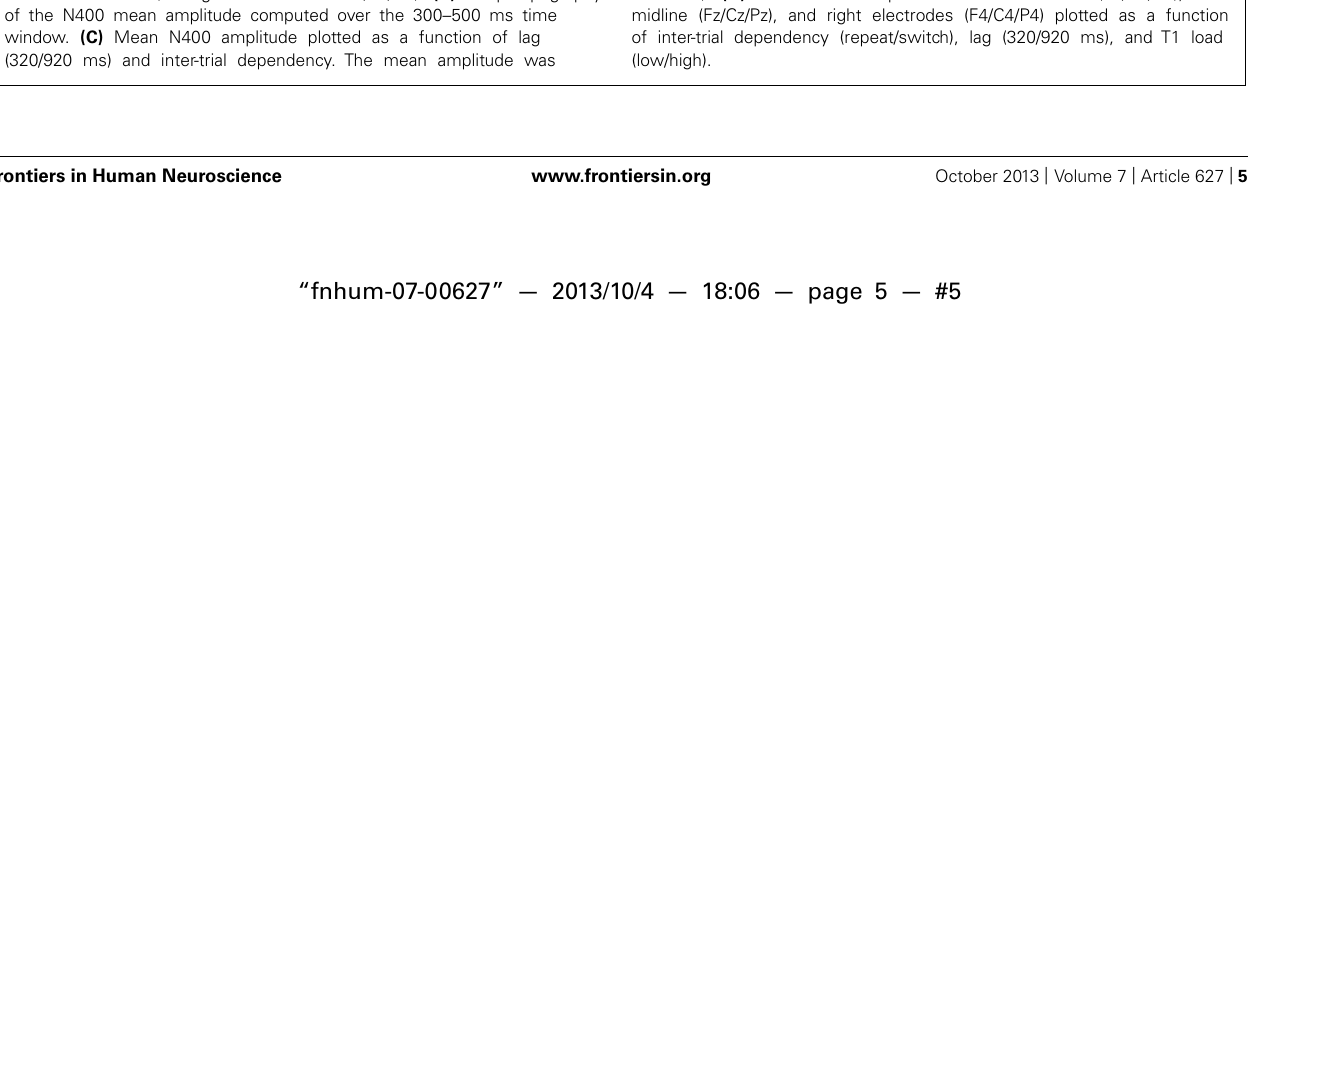
FIGURE 3 | Electrophysiological results from Experiment 2 . (A) Mean unrelated-related differences waves illustrating the N400 measured at central electrodes (average at electrodes C3/Cz/C4). (B) Scalp topography of the N400 mean amplitude computed over the 300–500 ms time window. (C) Mean N400 amplitude plotted as a function of lag (320/920 ms) and inter-trial dependency. The mean amplitude was